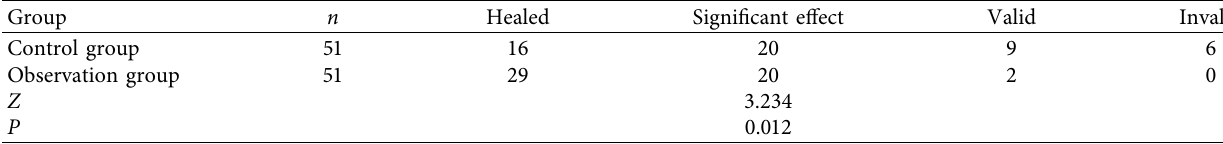
Table 1: Comparison of clinical symptoms of patients ( n , %).